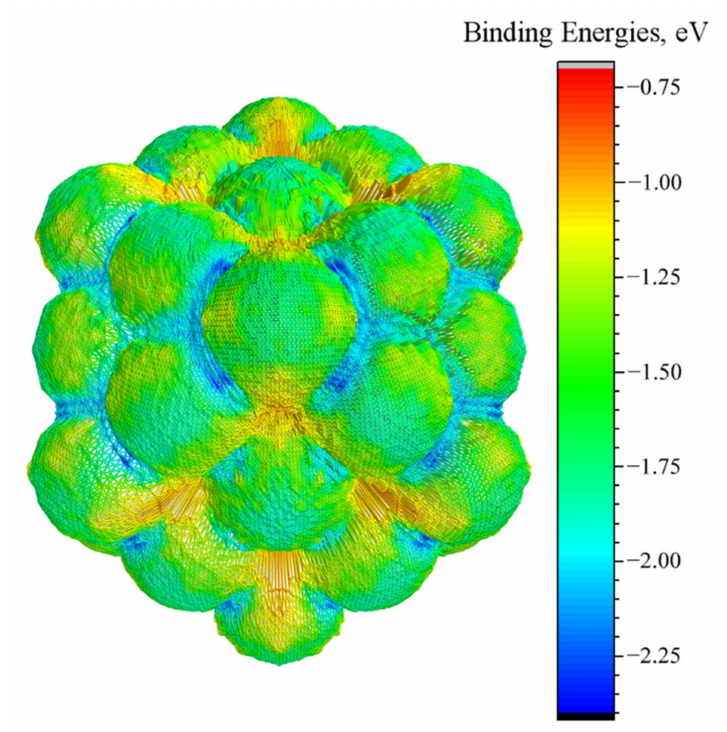
Figure 5. Energy surface of Pd 55 predicted by trained SMV ML method. A grid with steps π /100 for ϕ and θ was